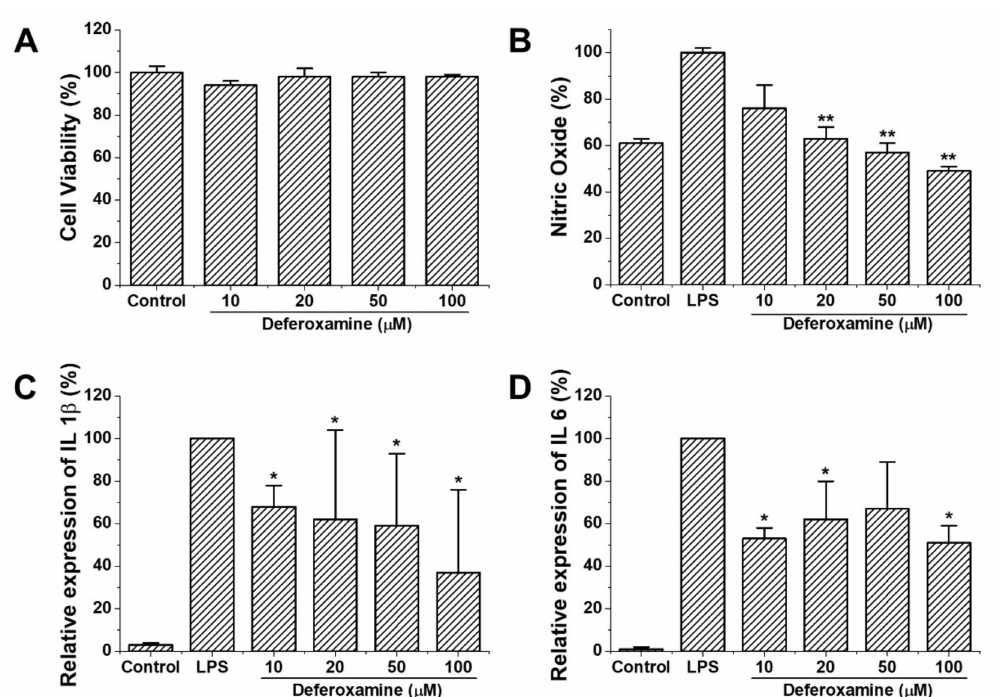
Figure 1. Cell viability and anti-inflammatory effect of deferoxamine in RAW264.7 cells. ( A ) The cell viability of DFO was assessed using a CCK-8 assay kit in RAW264.7 cells. ( B ) NO release of DFO in RAW264.7 cells. Cells were incubated in the presence of different concentrations of DFO and 0.1 µ g/mL LPS for 20 h. Then, the culture supernatant was analyzed for NO ( C , D ) IL-1 β and IL-6 expression at different concentrations DFO-treated RAW 264.7 cells analyzed with qPCR. ( A – D ) Cells were treated with different concentrations of DFO. The data are expressed as mean ± standard deviation. Data show mean ± standard deviation values of three independent experiments. * p < 0.05 and ** p < 0.01 indicate significant differences compared to the control value (100%).